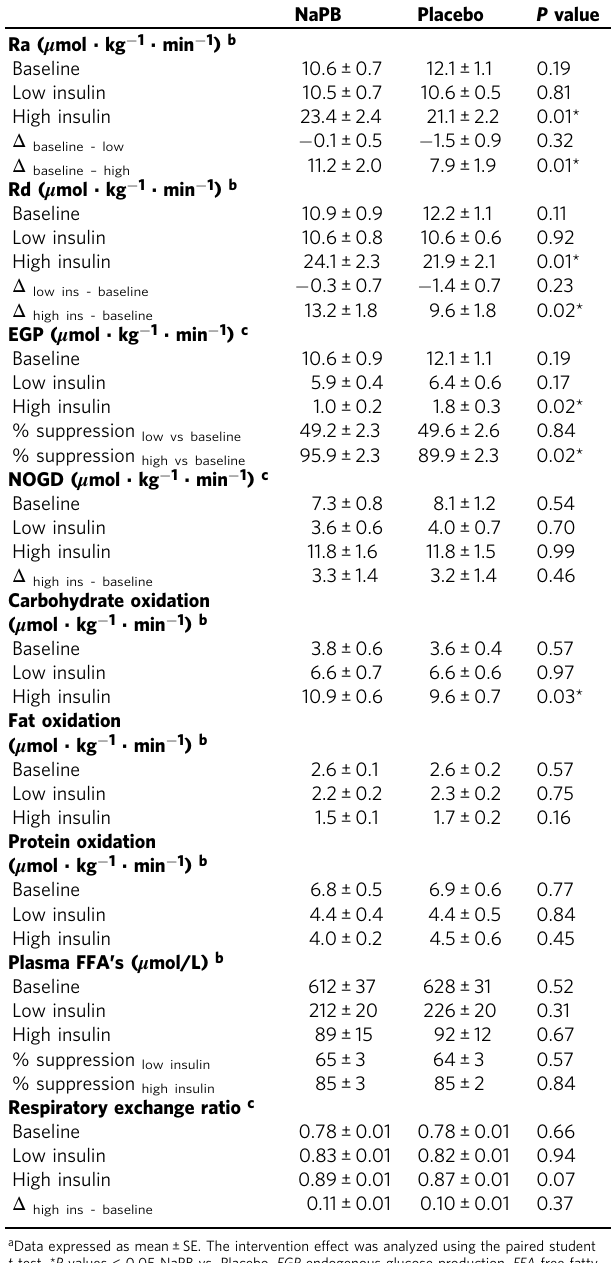
Table 2 NaPB treatment improved peripheral insulin sensitivity and whole-body carbohydrate oxidation a . NaPB Placebo